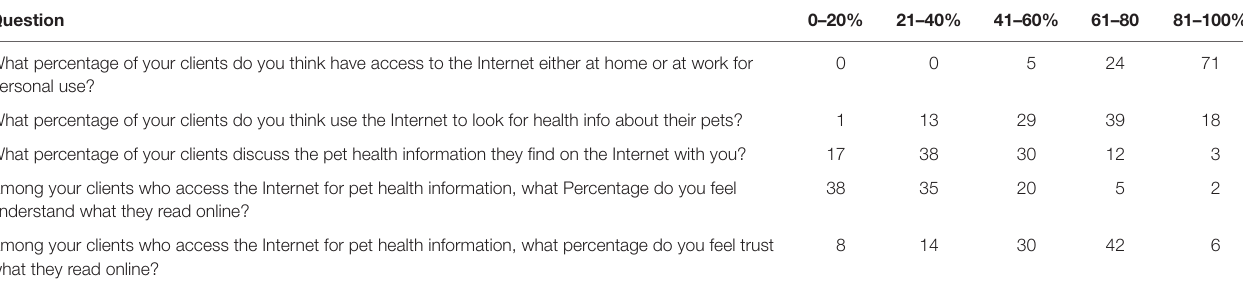
taBlE 1 | Veterinarians’ responses to statements about clients’ use and understanding of the Internet ( n =